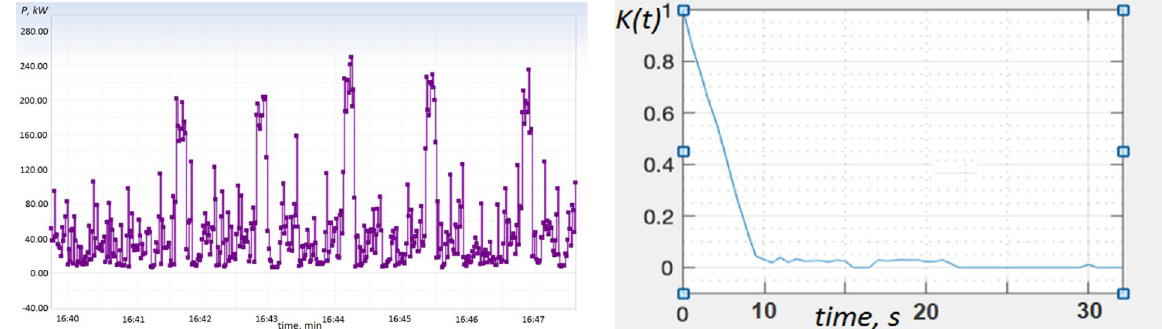
Figure 5. Fragment of the curve of active power consumption hydrocyclone feed pump with a VFD and his NCF.